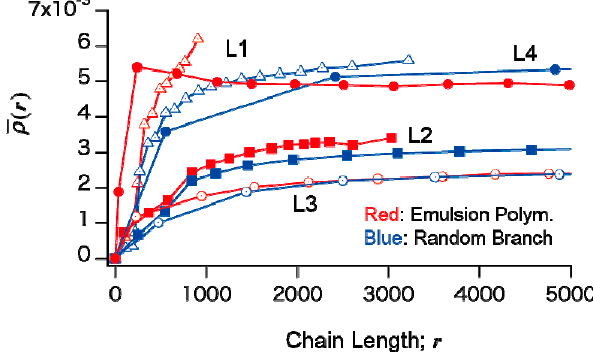
Figure 12. Expected branching density of the polymer with chain length r , for living emulsion polymerization (red) and random branching (blue).